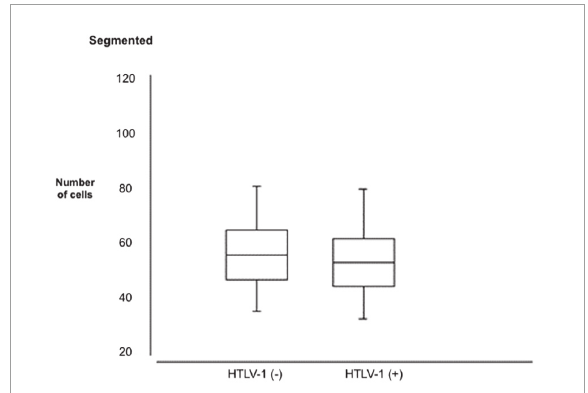
FIGURE2 Segmented distribution in patients with negative and the human T-lymphotropic virus type 1 (HTLV-1) positive.